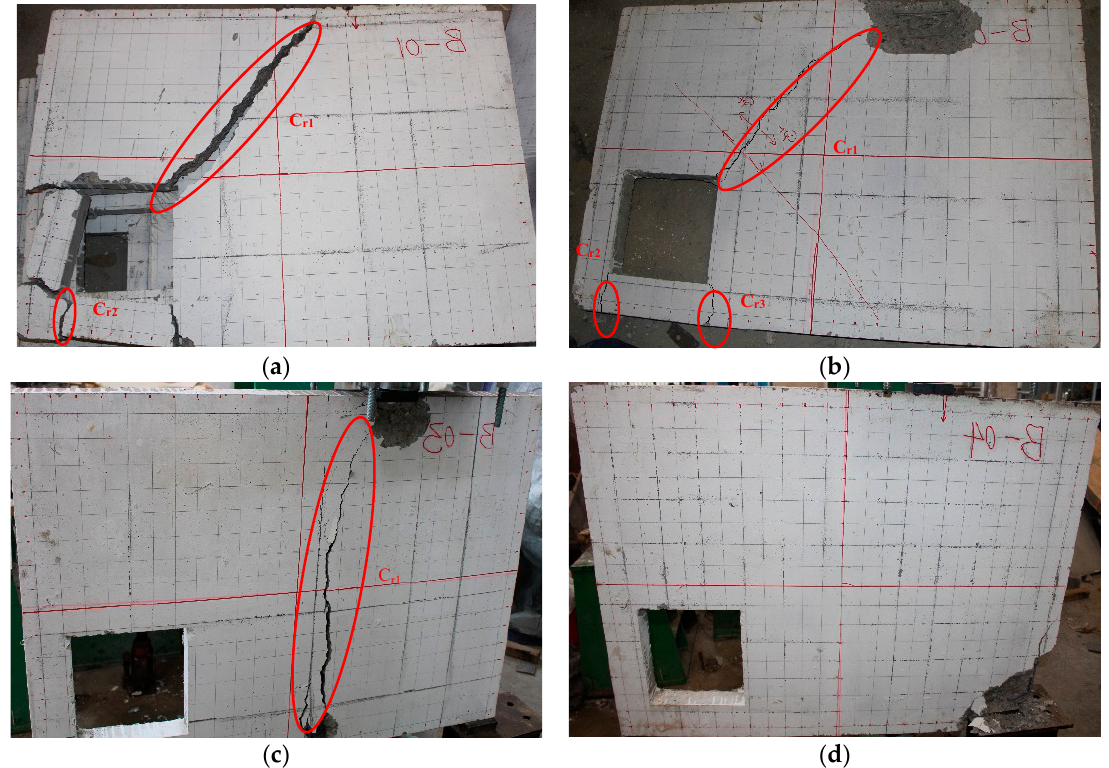
Figure16. FailurepatternsoftheGroupBirregularconcretedeepbeams: ( a )specimenB-01; ( b )specimen Figure 16. Failure patterns of the Group B irregular concrete deep beams: ( a ) specimen B-01; ( b ) B-02; ( c ) specimen B-03; ( d ) specimen specimen B-02; ( c ) specimen B-03; ( d ) specimen B-04